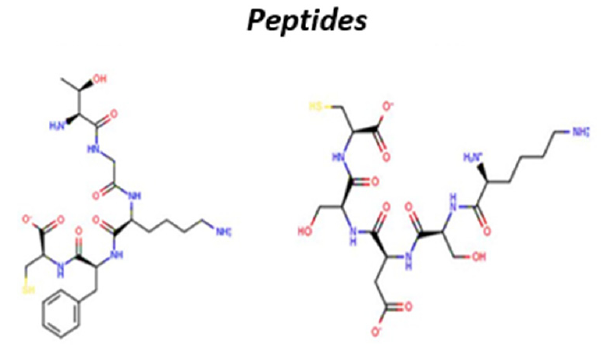
Figure 2. Sketches of oligopeptides.